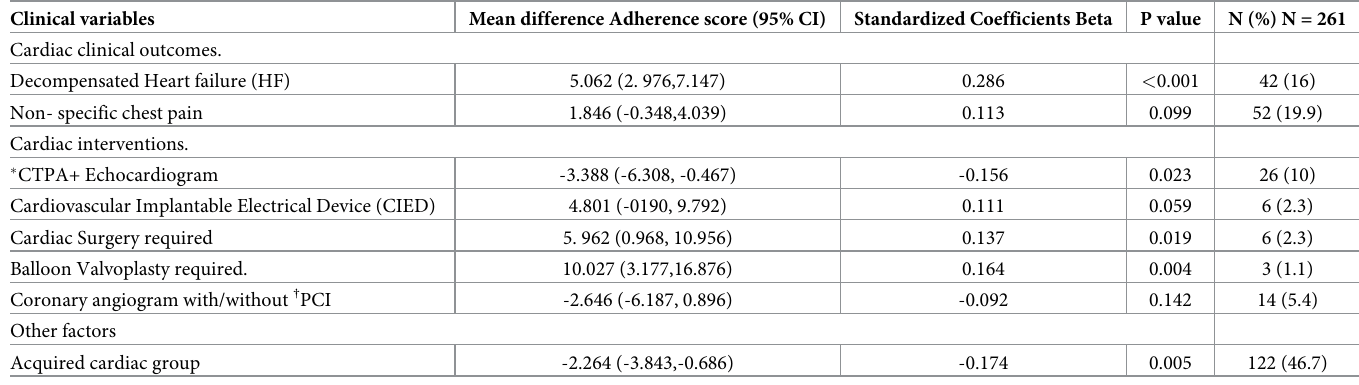
Table 2. Multivariable linear regression model results for the adherence score versus maternal cardiac clinical variables.